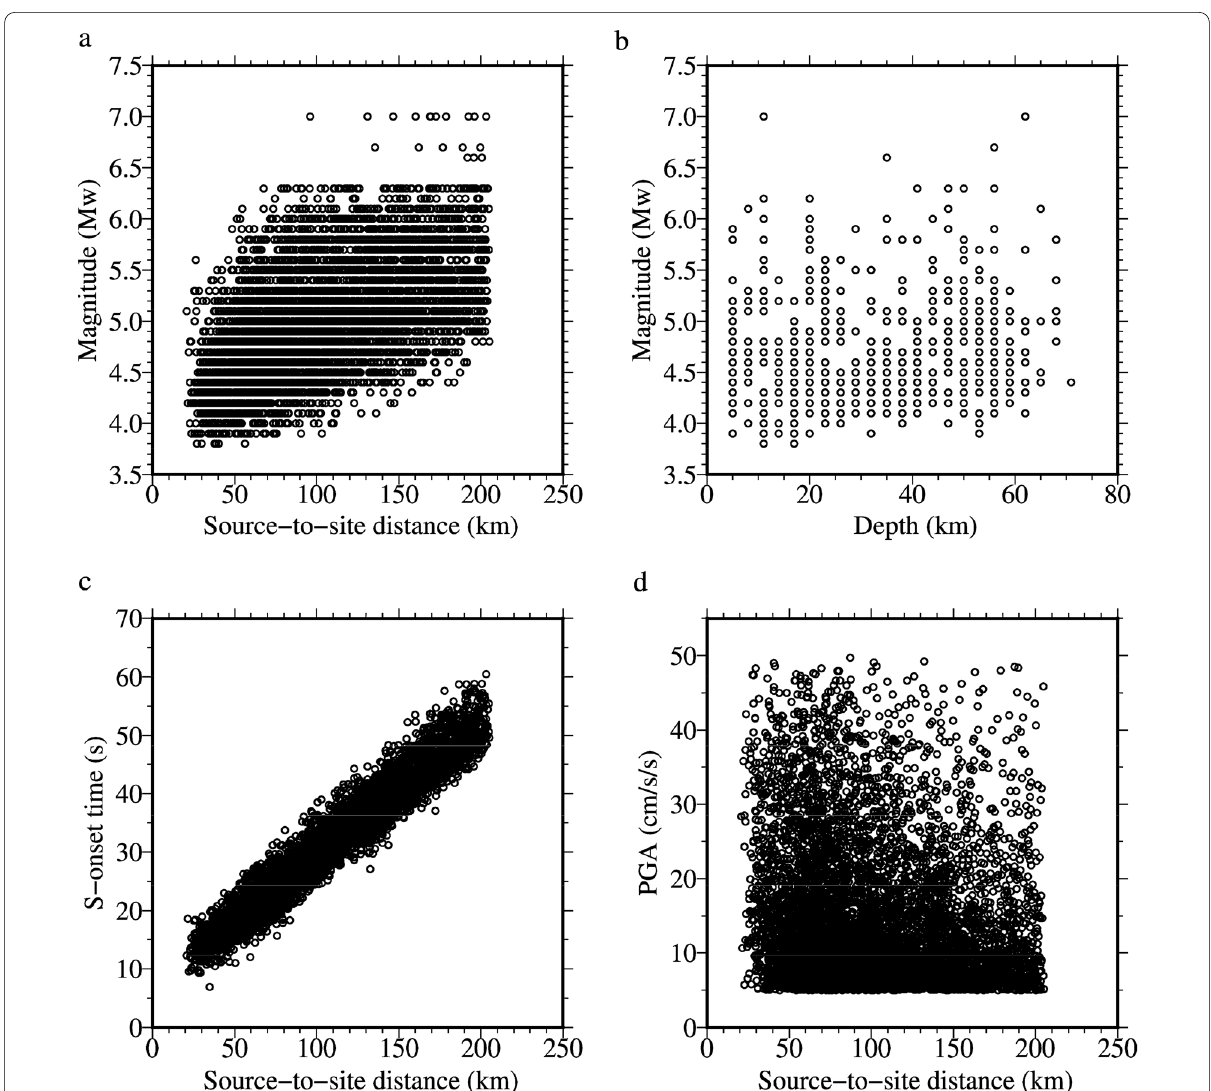
Fig. 2 General distribution of data in terms of magnitude and distance a , magnitude and depth b , S-onset time and distance c , and PGA and distance